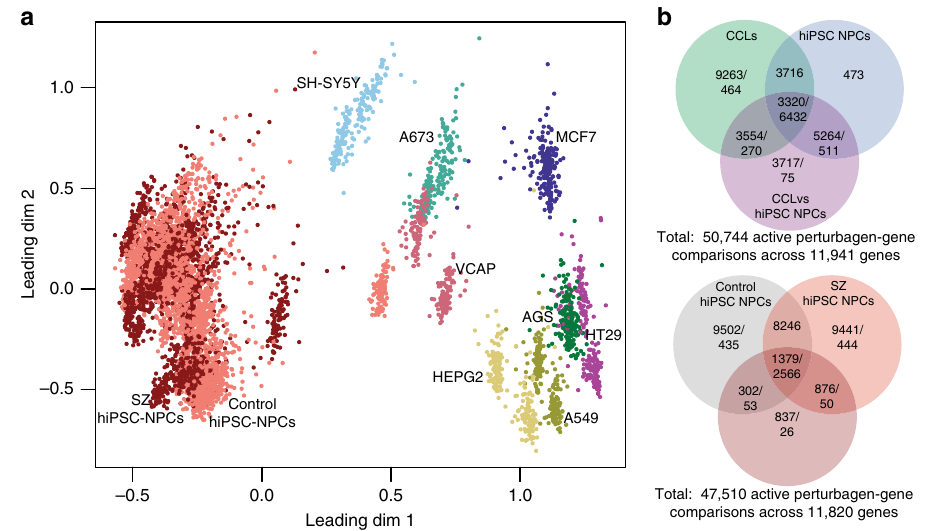
Fig. 2 Global summary of expression trends and frequently perturbed genes in hiPSC NPCs and CCLs. a Multi-dimensional scaling plot of normalized expression data for all drug-induced gene expression pro fi les across each hiPSC NPC and CCL. Each point represents the normalized gene expression corresponding to a single experiment. b Venn diagrams showing drug perturbation gene differential expression results by comparison type. Drug-gene perturbagen (DGP) comparisons were de fi ned as active (abs-RZS > 2) in one or more of the four within-cell type (CCL, hiPSC NPC, SZ hiPSC NPC, and control hiPSC NPC) comparisons and two between cell-type comparisons (CCL vs. hiPSC NPC, control vs. SZ hiPSC NPC), one row per DGP-comparison combination. Three circles are required, because a particular DGP test may independently be called as active in the CCLs, hiPSC NPCs, and/or CCL vs. hiPSC NPC tests (or control hiPSC NPCs, SZ hiPSC NPCs, and/or control vs. SZ hiPSC NPCs). The fi rst number in each section is the number of